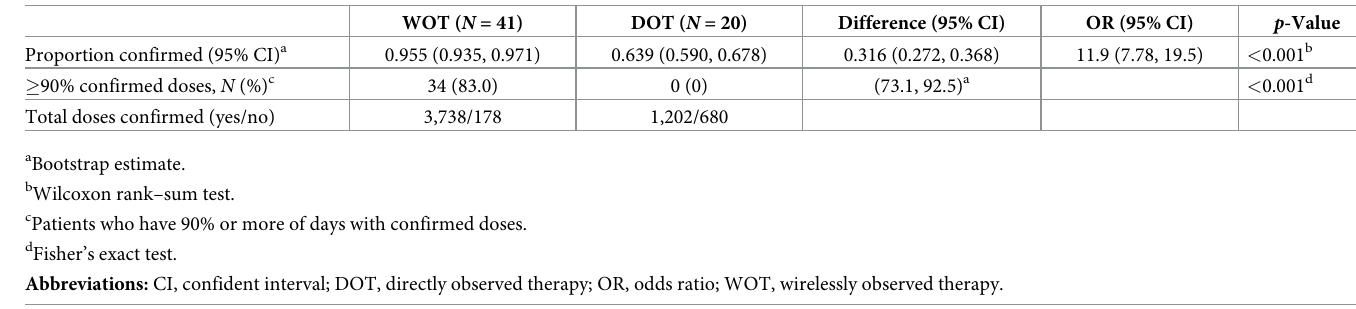
Table 4. Secondary analysis for comparing proportion of witnessed doses between two treatment arms: days with held doses are excluded, 1 or more tablets are counted as confirmed